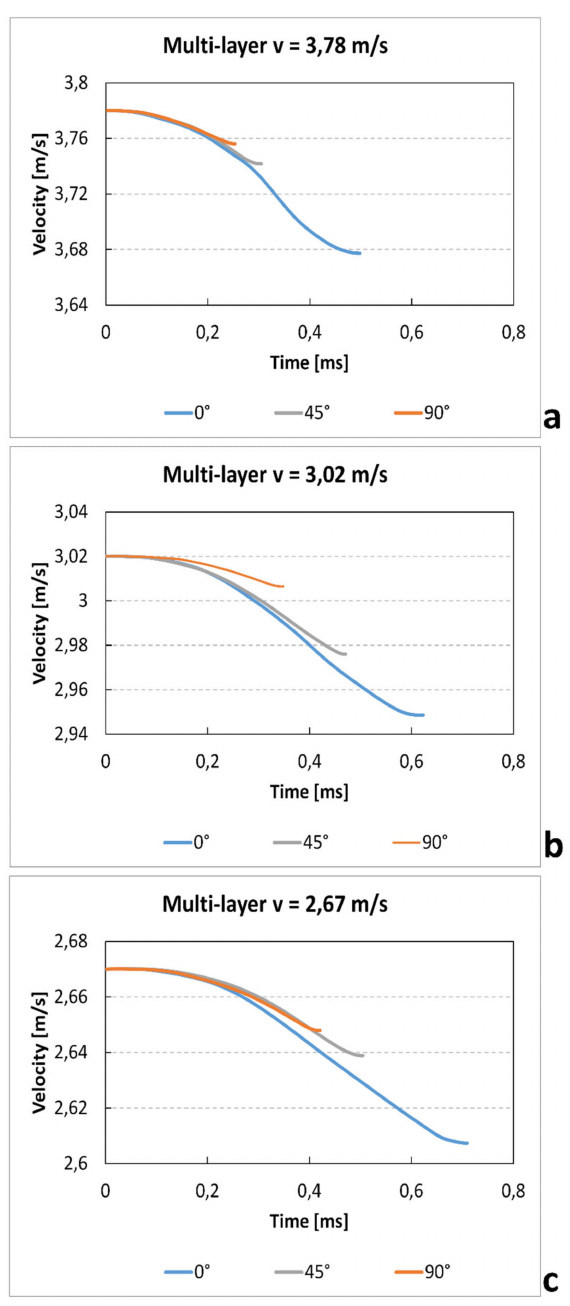
Figure 17. Multilayer velocity–time curves for di ff erent raster angles and